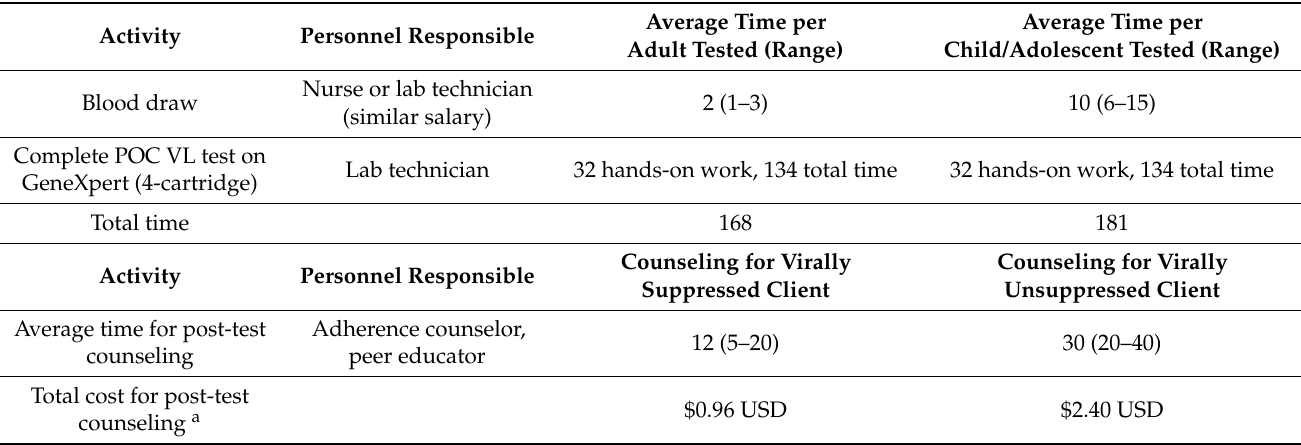
Table 4. Time and motion observations on VL testing comparing pregnant women and children and post-test counseling depending on viral suppression status